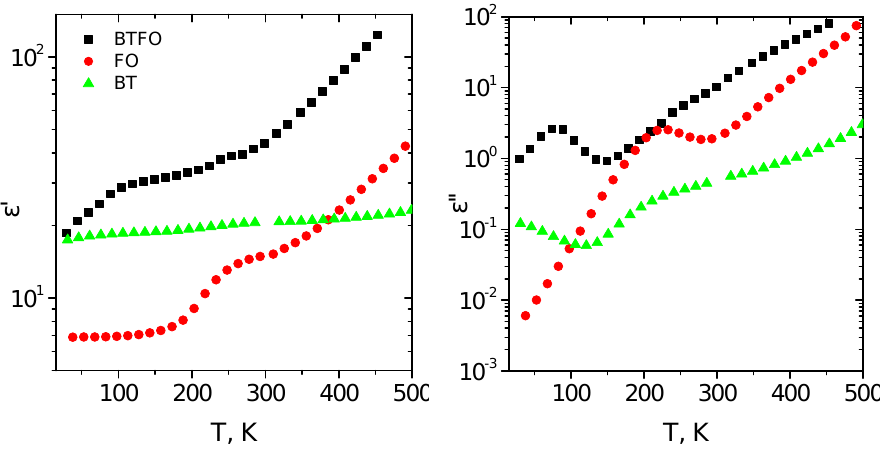
Figure 4. Real and imaginary parts of the dielectric permittivity of the ceramic composites at the frequency of 100 kHz as a function of